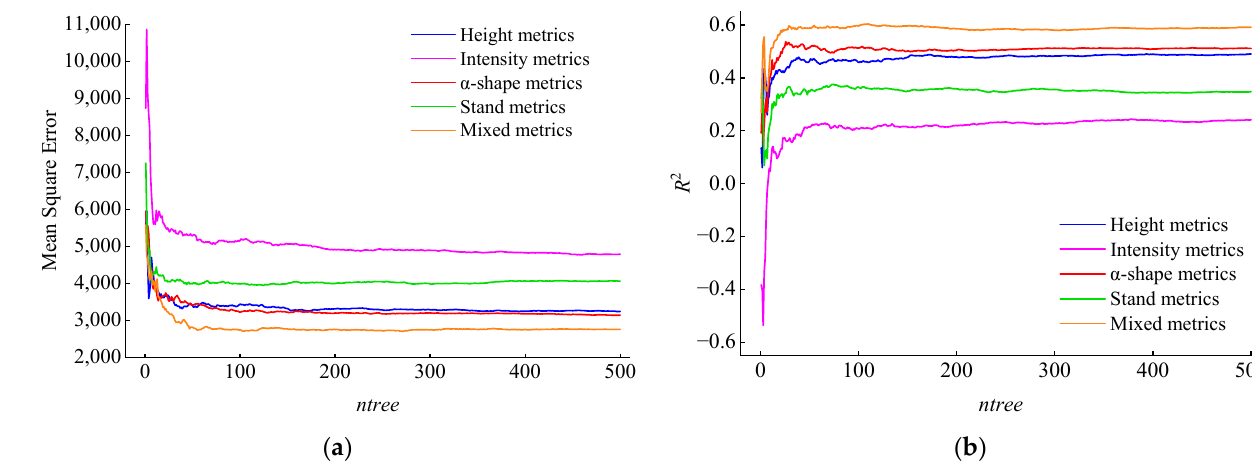
Figure 5. Hyperparameter tuning results for random forest: ( a ) The relationship between MSE and the number of trees; ( b ) The relationship between R 2 and the number of trees.